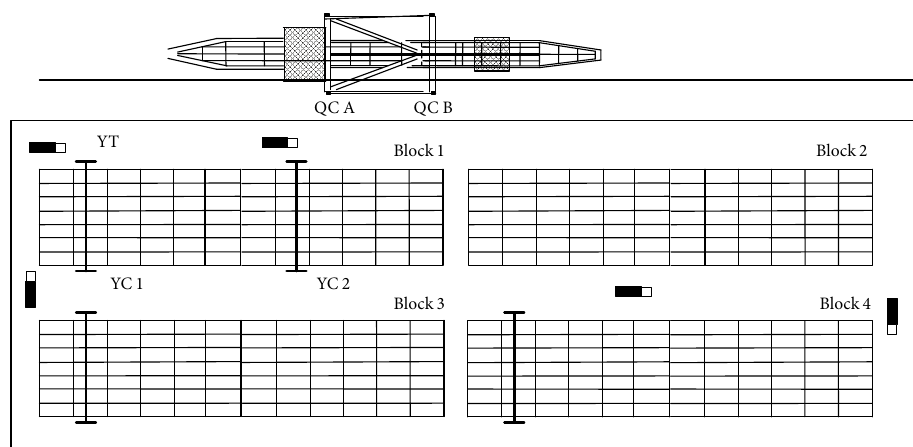
Fig. 1. A layout of a container-loading terminal